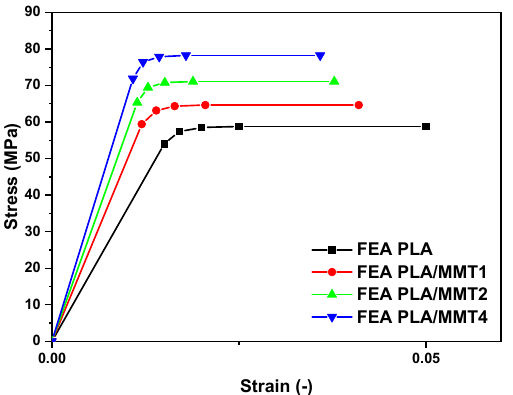
Figure 8. Curve fitting between the experimental and the FEA generated stress–strain curves of the PLA and PLA/MMT.